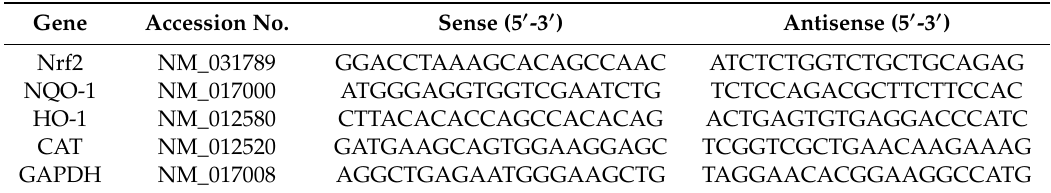
Table 1. Primer sequences for RT-PCR